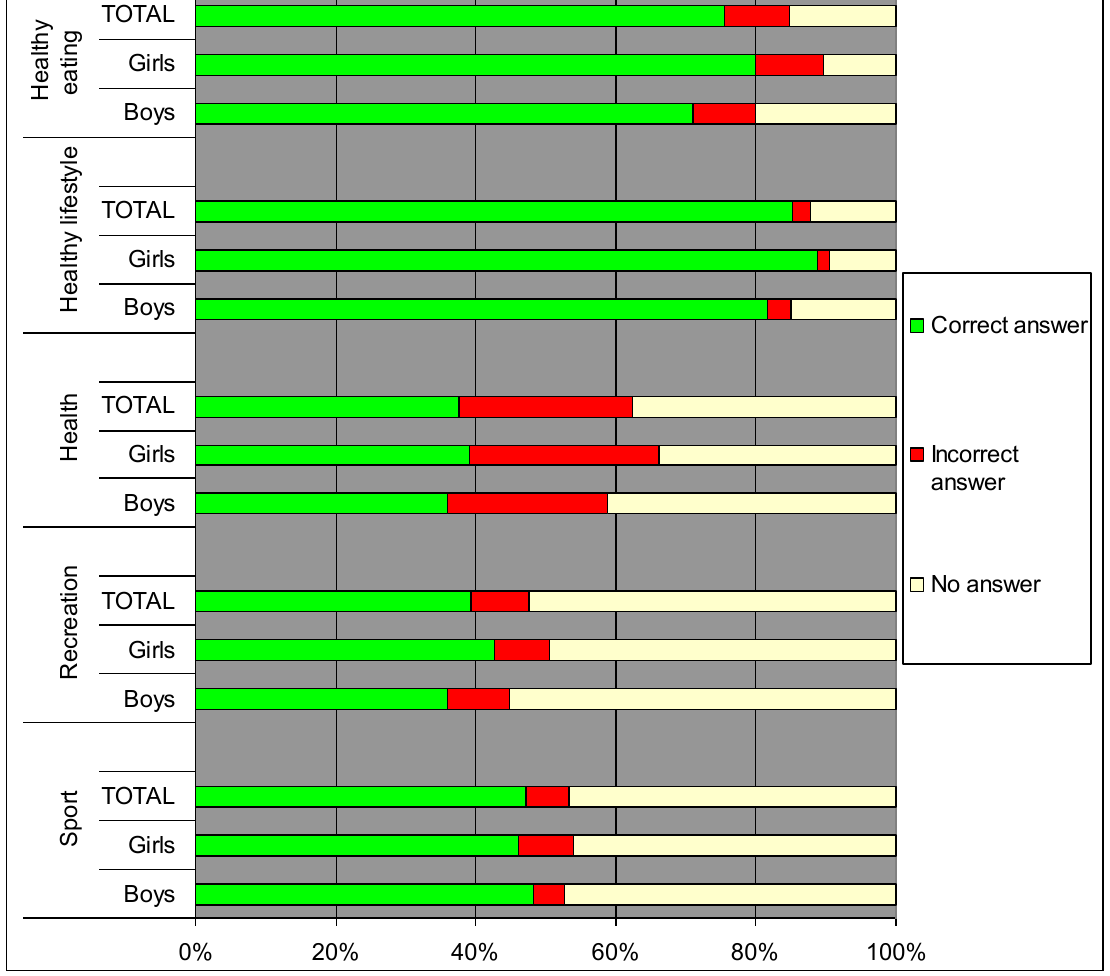
Fig. 2. The level of respondents’ knowledge on physical education